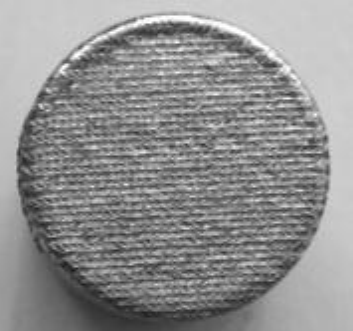
Figure 4. Macroscopic details of the surface of the laser re-melted sample prior to the cavitation erosion experiments (15.8 mm sample diameter).